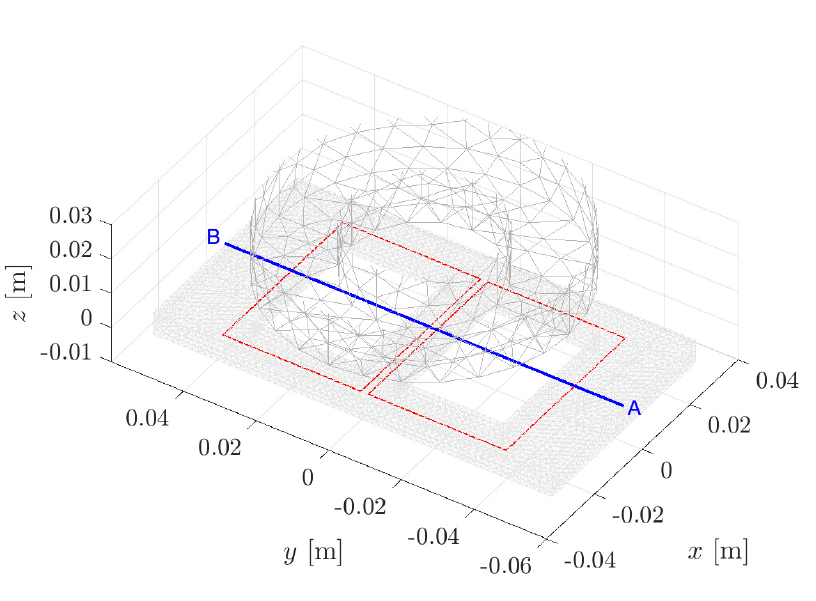
Figure 11. Tetrahedral mesh of the “Bath plate” model used for indirect CM–BEM simulations (field calculation line A-B is depicted in blue; virtual loops are depicted in